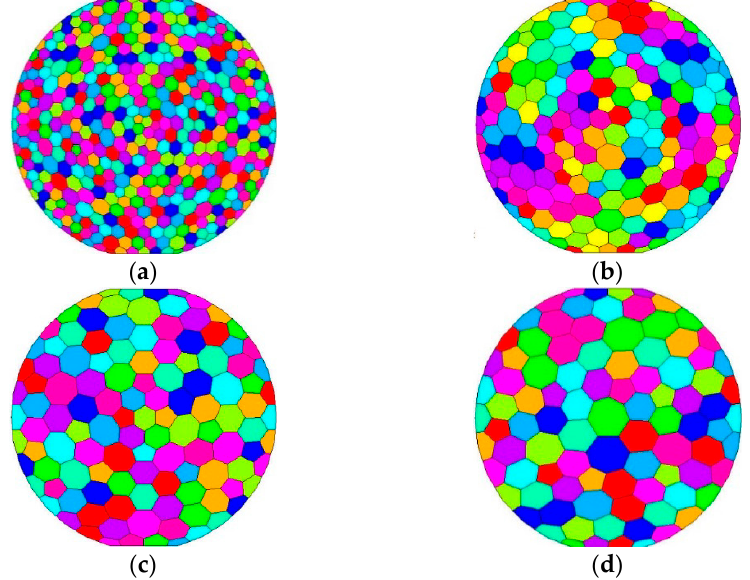
Figure 7. Crystal structure models of river ice with different grain sizes: ( a ) grain diameter d = 4 mm; ( b ) grain diameter d = 6 mm; ( c ) grain diameter d = 8 mm; and ( d ) grain diameter d = 10 mm.